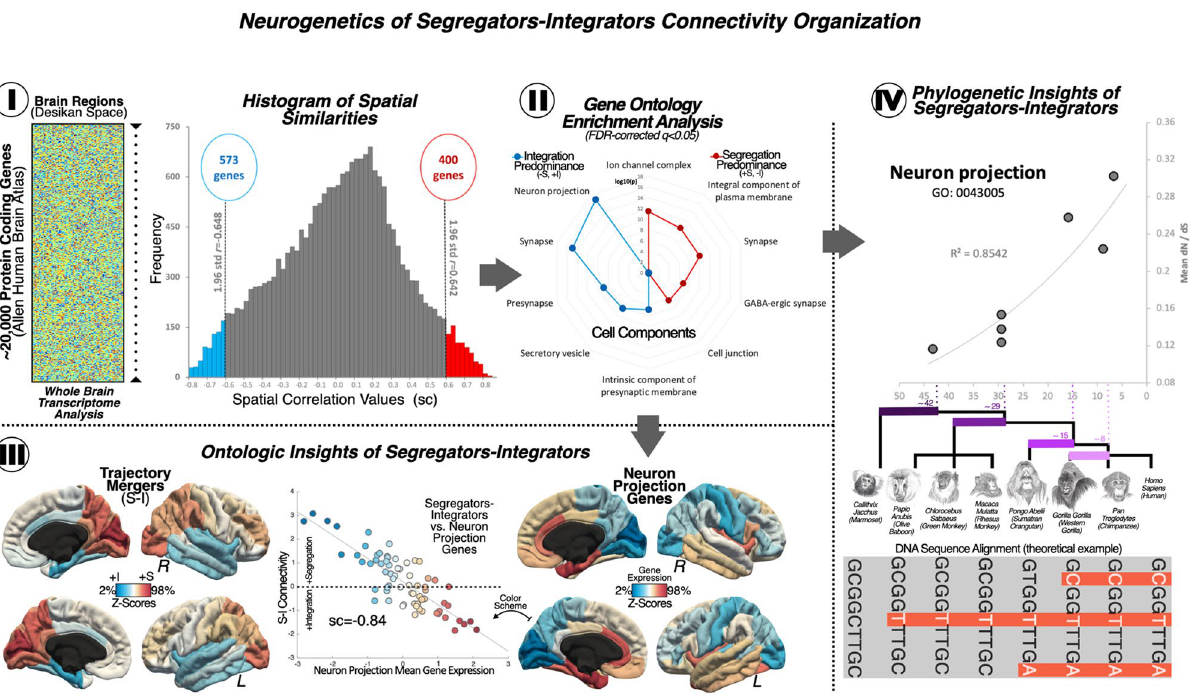
Figure 2. Linking brain functional organization to genetic expression. (I) Spatial similarity analysis. On the left, a representation of the whole-brain human transcriptome information from the Allen Human Brain Atlas (AHBA) distributed in the Desikan-Killiany (DK) atlas surface anatomical transformation is offered. The genetic data was organized in a bi-dimensional matrix that contained the cortical expression of 20,737 protein-coding genes from the AHBA by 68 cortical brain regions, the parcellation obtained from the DK atlas. On the right, the results of the spatial similarity are shown. Spatial comparisons were done between the mean connectivity map— resulting from subtracting the mean connectivity maps corresponding to the early and late trajectory mergers — and cortical gene expression maps from all genes of the AHBA transcriptome. A threshold set at ± 1.96 standard deviation above or below the mean was used to identify the genes with statistically significant similarity scores. In the histogram, the area highlighted in blue corresponds to the early trajectory mergers , while the area in red represents the late trajectory mergers . (II) Enrichment analyses. Using data from the Gene Ontology resource we investigated the cellular components linked to the genes related to the early or late trajectory mergers . In the radar chart, the blue dots represent the cellular components associated with brain areas showing an integrating predominance, and the red dots represent those components associated with brain areas displaying a segregating predominance. The numbers inside the radar chart are the p values. The results are statistically significant and corrected for multiple comparisons (FDR q < 0.05). (III) Ontologic Insights of Segregators-Integrators. The relationship between the trajectory mergers mean connectivity map and the brain map capturing the cortical expression of the neuron projection has been illustrated. A high correlation is found between these two maps, indicating that brain areas with integrating tendency are related to the expression of the neuron projection cellular component. In relation to the trajectory mergers mean connectivity map, brain areas in red tones are related to segregation while blue tones are related to integration. The same color scheme was used for the neuron projection brain map and the line chart, where warmer tones indicate higher gene